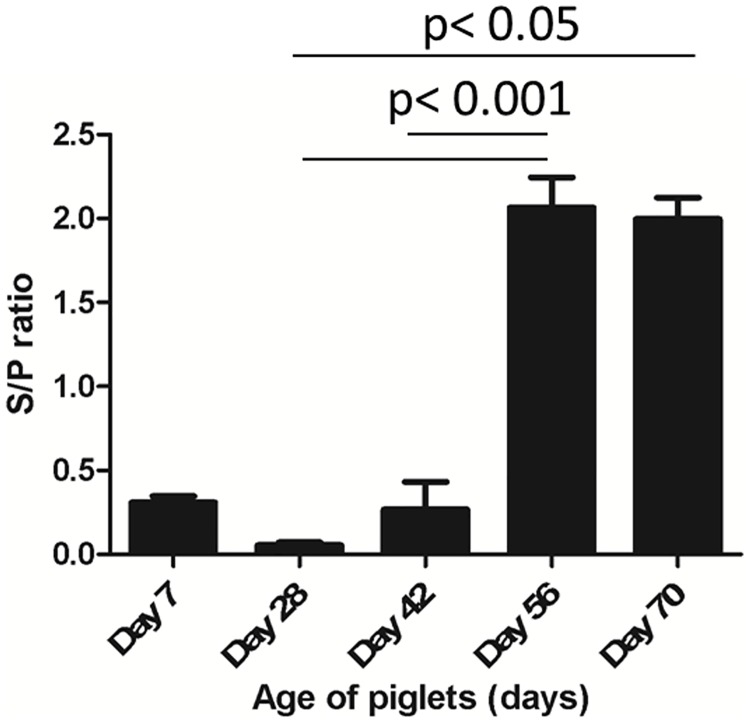
PRRSV specific antibody response.The figure illustrates the reactivity of maternally derived antibody, and vaccine derived antibody to PRRSV in plasma detected by ELISA. The optical density (OD) values in the Y-axis represents sample to positive (S/P) ratio, and a S/P value of 0.4 was considered as threshold for positivity of antibody response. Values in X-axis represents the piglet ages at which blood samples were evaluated. Blood sampling at day 28 and day 56 were performed right before the primary and the booster vaccination, respectively (indicated by asterisk).